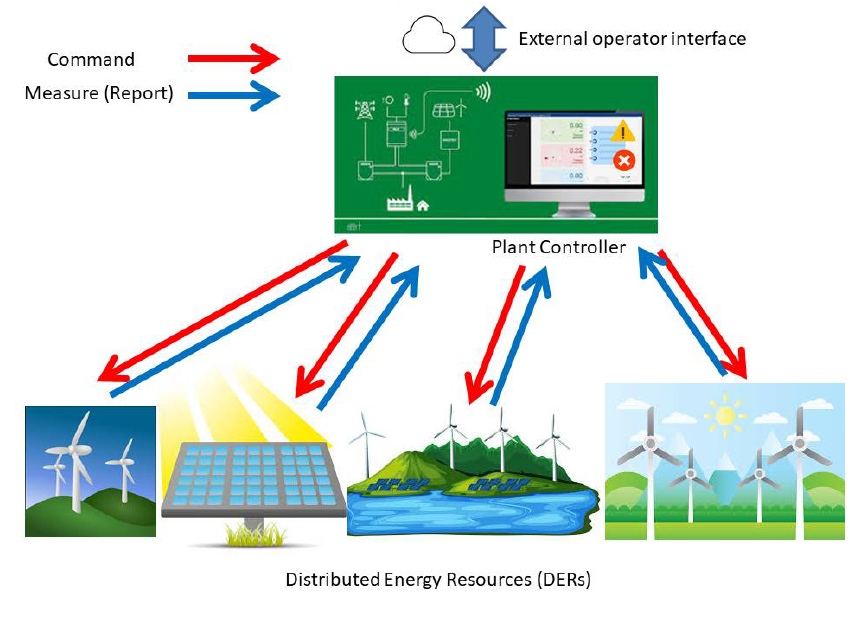
Figure 1. Reference